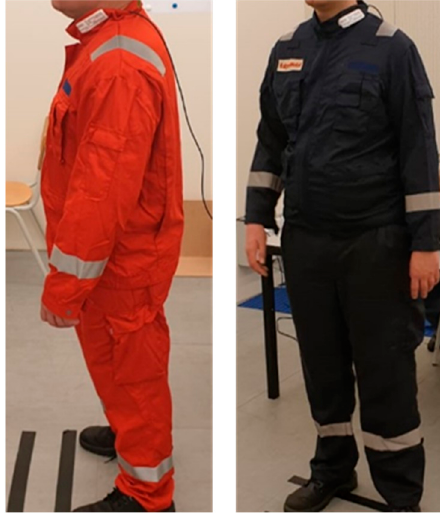
Figure 1. Protective clothing for process operators.